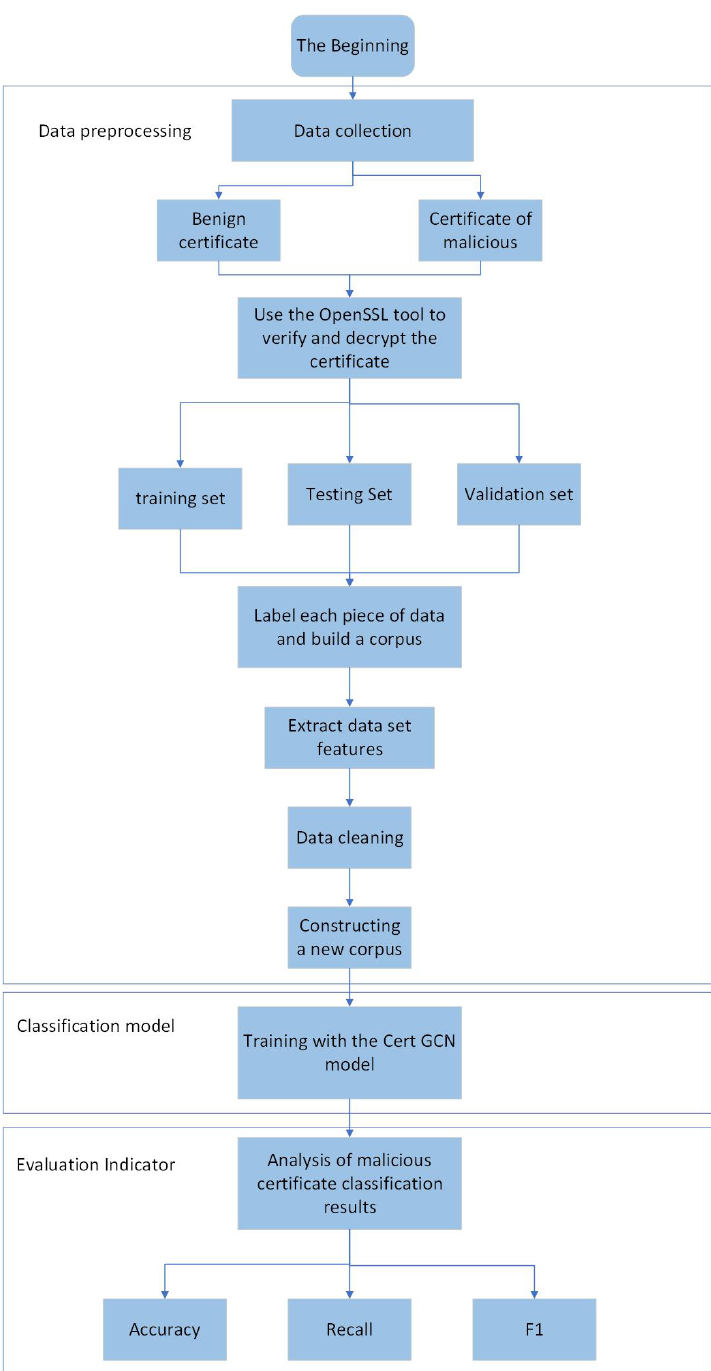
Figure 3. Malicious digital certificate detection